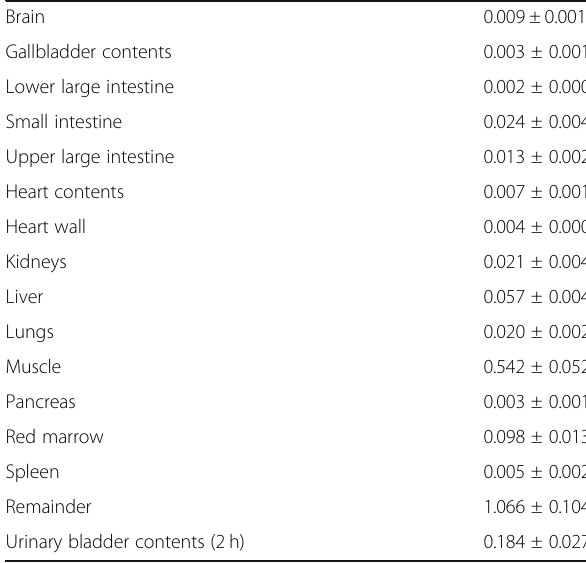
Table 3 Residence times of [ 18 F]DiFA for measured source